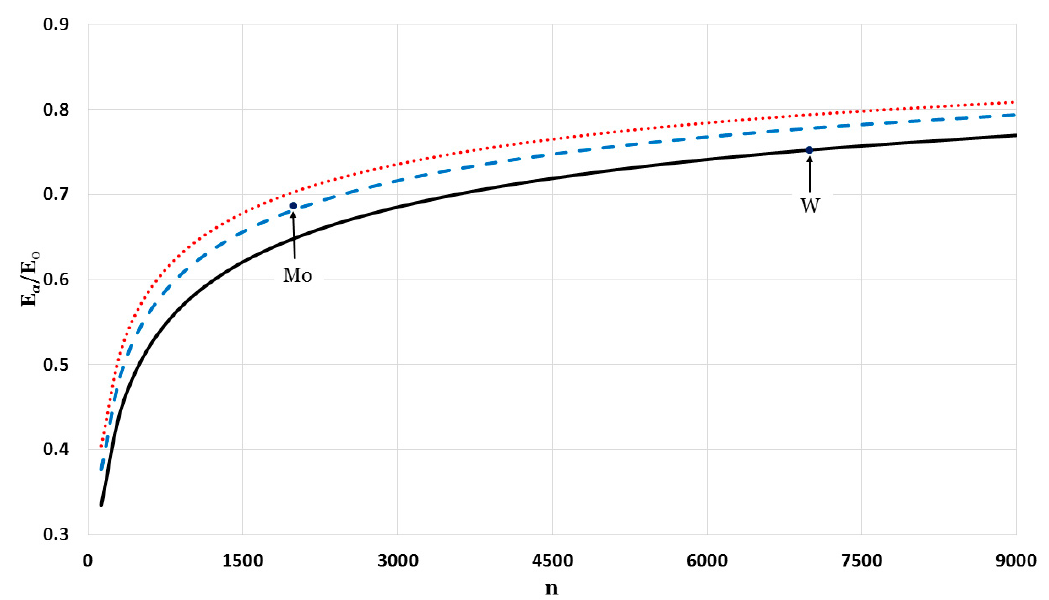
Figure 8. The variation of the relative cohesive energy of nanoparticles in a face-centered cubic structure as function of the number of atoms for m = 3 and di ff erent values of α : 2.0 (black solid line), 2.1 (blue dashed line), and 2.2 (red dotted line). The experimental values [23,24] are denoted by dark blue circles.